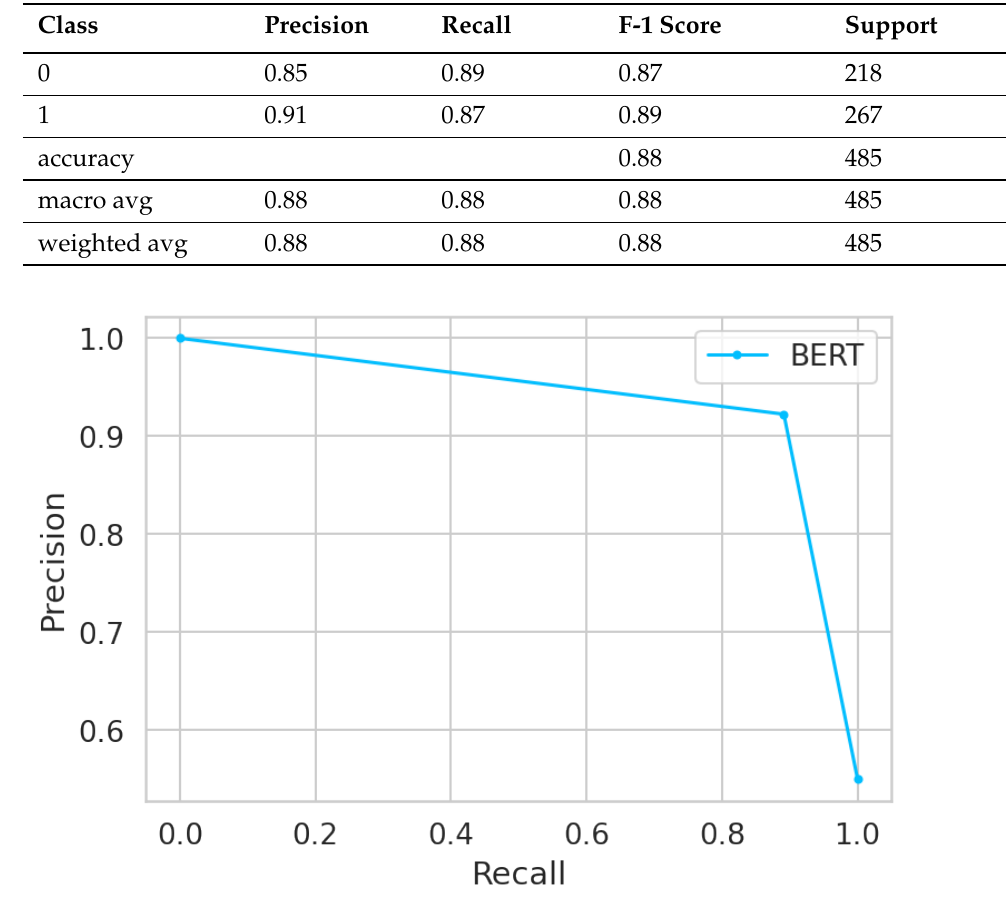
Table 13. Classification report for RoBERTa.